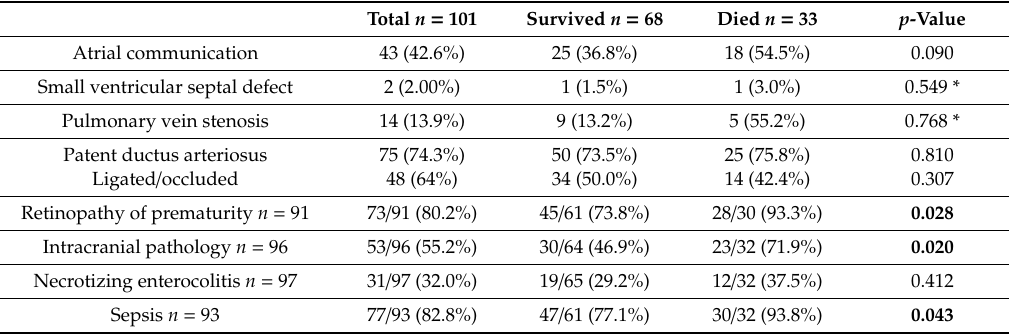
Table 2. Associated findings and